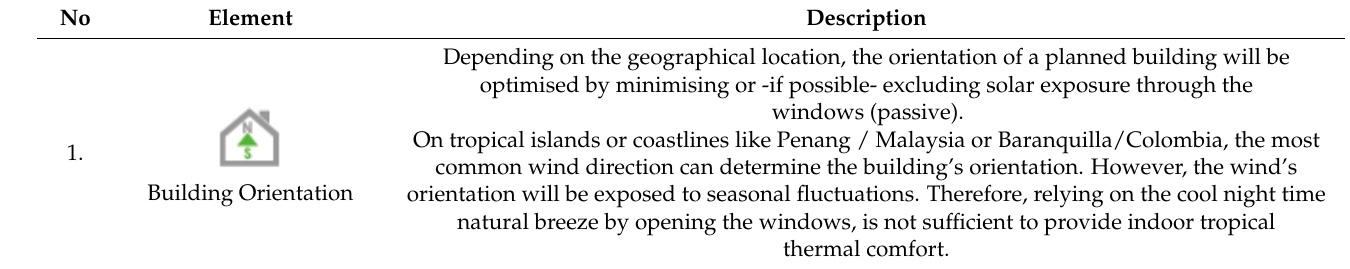
Table 1. Details of the Adjusted Seven to Eight Modules and Benchmarks of a Tropically Adapted Passive House (PH2).